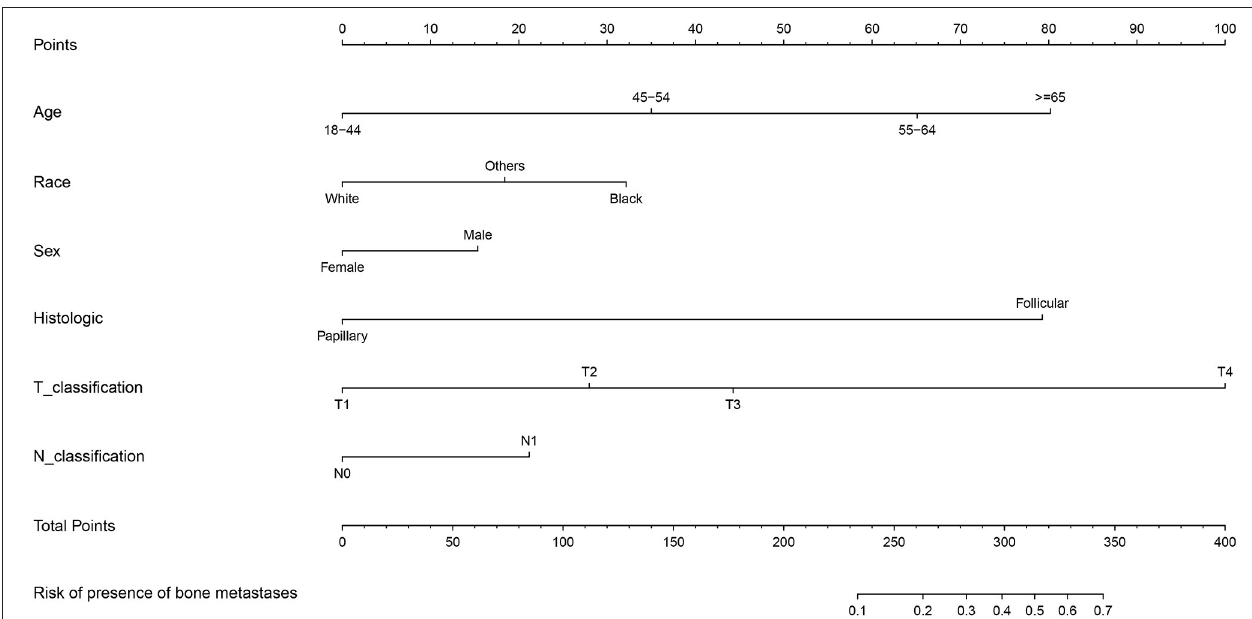
FIGURE 3 | Nomogram for predictors of the presence of SBM in the patients with DTC. SBM, synchronous bone metastasis; DTC, differentiated thyroid